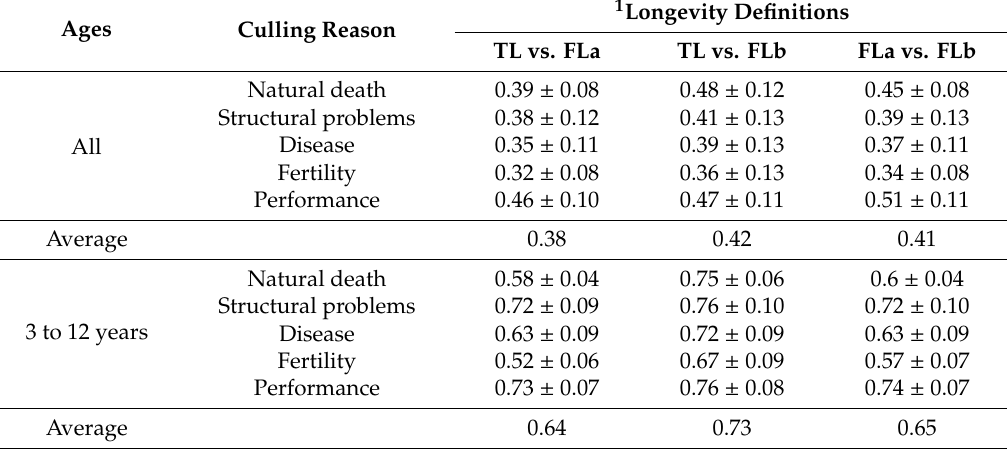
Table 6. Average ( ± SE) genetic correlations estimated between the di ff erent longevity definitions considering all ages (i.e., from 2 to 15 years) and ages between 3 and 12 years-old, for all groups of known culling